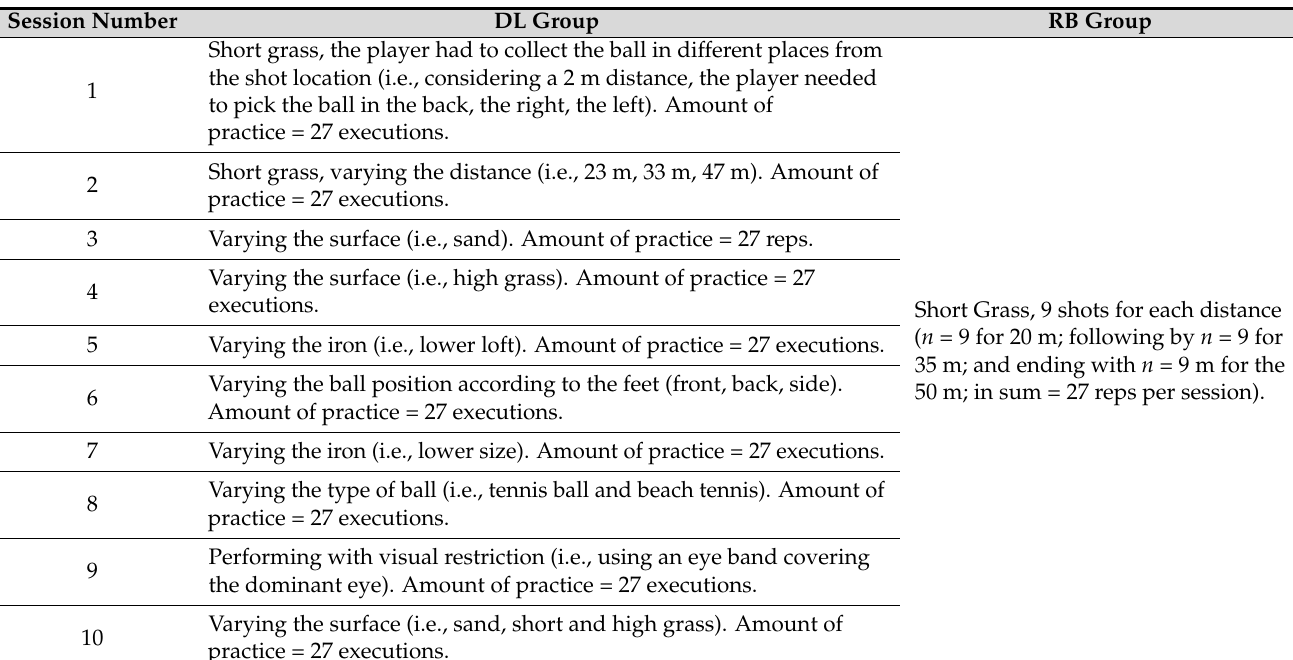
Table 2. Methodical differences between the control and DL